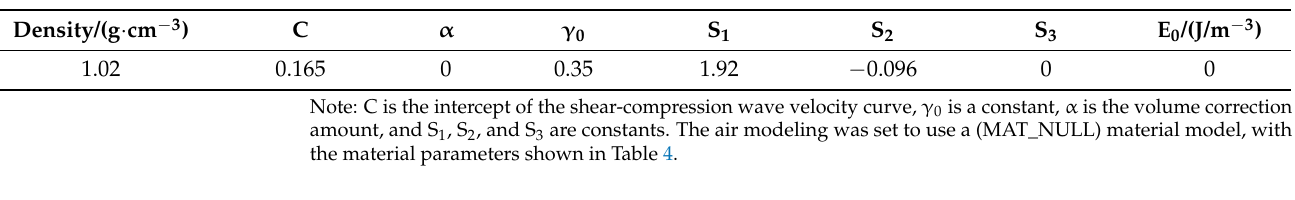
Table 3. Parameters of water materials.